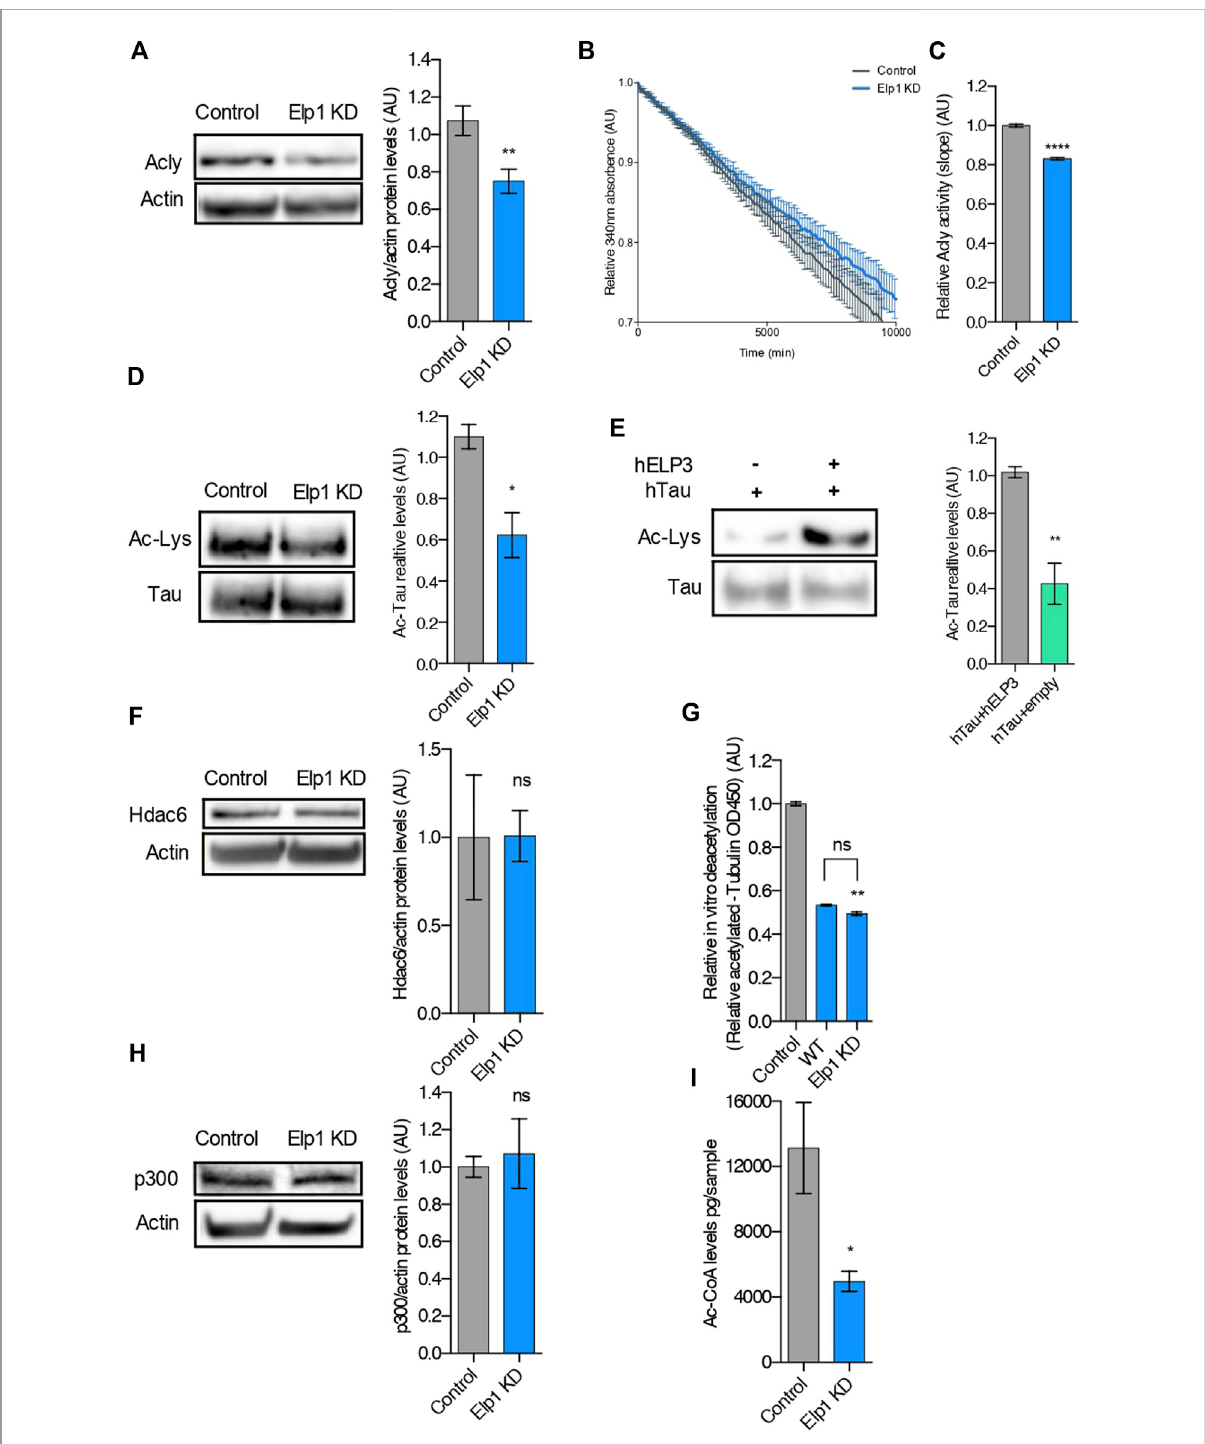
FIGURE 5 Tauishypoacetylated,aresultofimpairedproductionofacetyl-CoAuponElongatordepletion . (A) WesternblottingtodetectandquantifyAcly, and ß-Actin in control and Elp1KD cells extracts. Histograms of proportion of Acly expression to ß-Actin. (B,C) Analysis of Acly activity by malate dehydrogenase coupled method performed in control and Elp1KD cells lysates. Histogram of relative Acly activity over assay (B) and of slopes (C) from the linear phase of the reaction. (D) Immunoprecipitation followed by Western blotting to detect and quantify Acetylated Tau, in control and Elp1KD cells extracts. Histograms of proportion of acetylated lysine expression to Tau. (E) Immunoprecipitation followed by Western blotting to detectandquantifyacetylatedTau,inextractsfromHEK293cellstransfectedwithTau,Elp3oremptyvector.Histogramsofproportionofacetylated